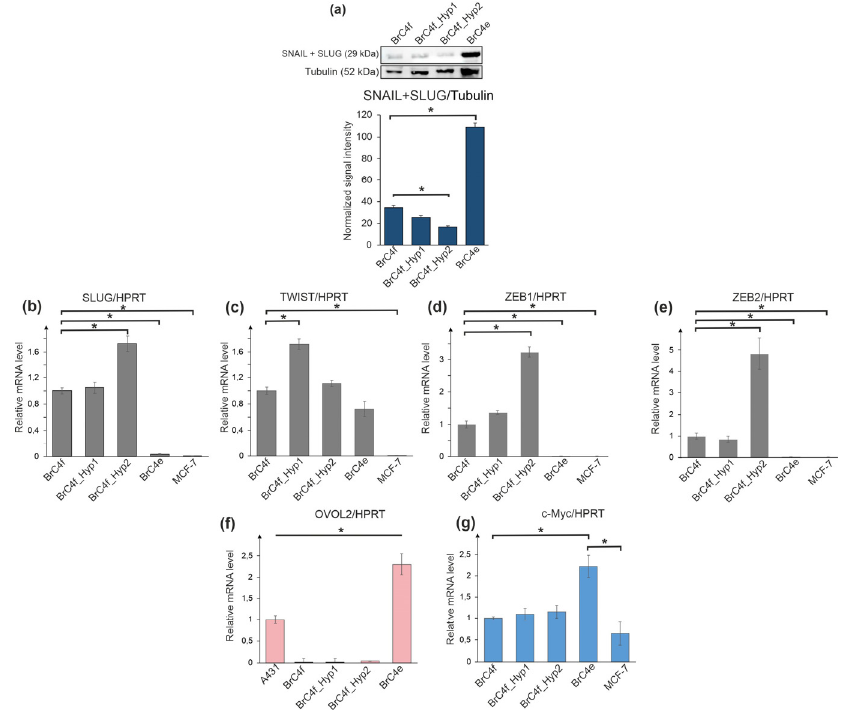
Figure 5. The analysis of markers of EMT and MET in model cells. ( a ) Protein levels of SNAIL/SLUG in cell culture transformation of fibroblasts. Quantitation of SNAIL/SLUG normalized by total beta-tubulin. * p < 0.05. Alteration of mRNA expression level genes associated with epithelial– mesenchymal transition and mesenchymal–epithelial transition. ( b ) SLUG; ( c ) TWIST1; ( d ) ZEB1; ( e ) ZEB2; ( f ) OVOL2; ( g ) c-MYC. The expression of specific mRNAs was normalized to the expression level of Hypoxanthine Phosphoribosyl transferase (HPRT) mRNA. Statistical analysis included the results of two independent experiments (mean ± SD). * The difference between the experimental group and the control (BrC4f) group were statistically significant at p <